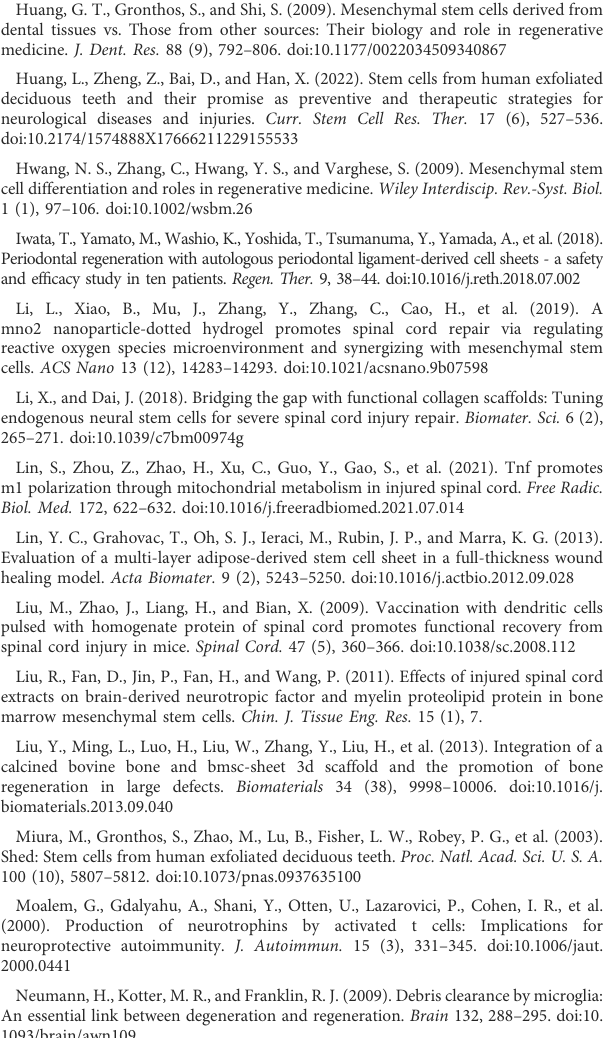
SUPPLEMENTARY VIDEO S1 Locomotion of rats in each group on the 60th day postoperatively. SUPPLEMENTARY FIGURE S1 The surgery process of SCI modeling. SUPPLEMENTARY FIGURE S2 IF staining of NeuN and Iba1 in Ctrl, SHED and hp SHED